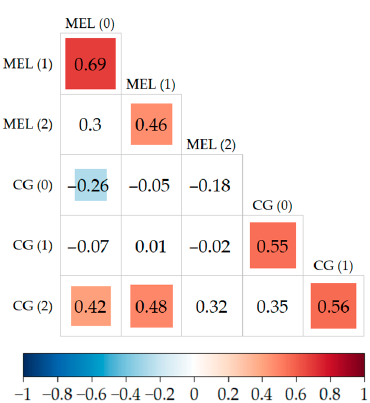
Figure 1. Correlations between the concentration of biomarkers at <4.5 h, 24 h, and after 7 days. Statistically significant relationships between biomarkers are marked in colour in the figure (the tiles contain the values of these correlations).